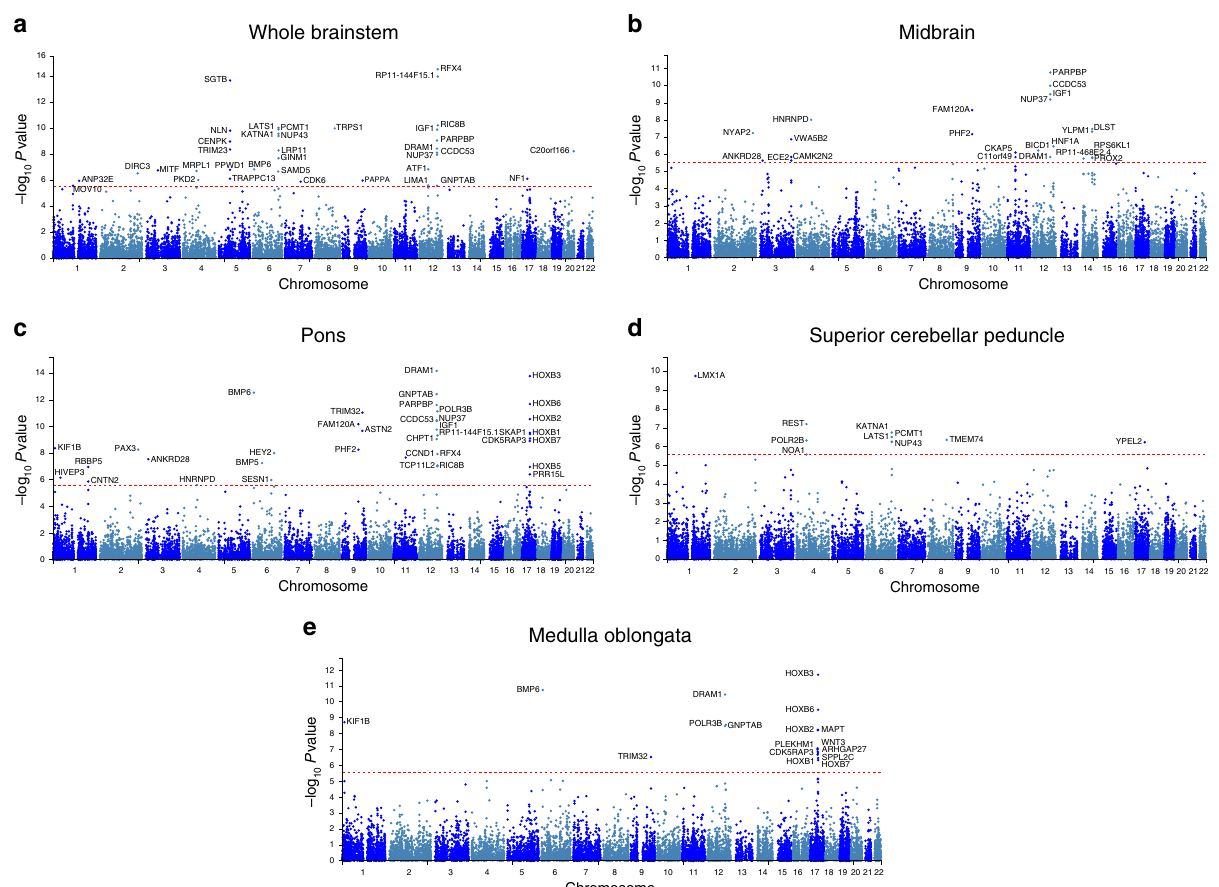
Fig. 2 Manhattan plots from the genome-wide gene-based association analyses for volumes of the whole brainstem. a midbrain b pons c superior cerebellar peduncle d , and medulla oblongata e in the discovery sample. Thirty-six genes were associated with whole brainstem volume and 22, 37, 10, and 17 genes were associated with volumes of the midbrain, pons, superior cerebellar peduncle, and the medulla oblongata, respectively. Twenty-two of the genes were only associated with whole brainstem volume, whereas 13, 14, 6, 5 genes were only signi fi cant for volumes of the midbrain, pons, superior cerebellar peduncle, and the medulla oblongata. The red horizontal lines indicate genome-wide signi fi cance threshold of two-sided P < 2.7e − 6, i.e., 0.05/ 18,447